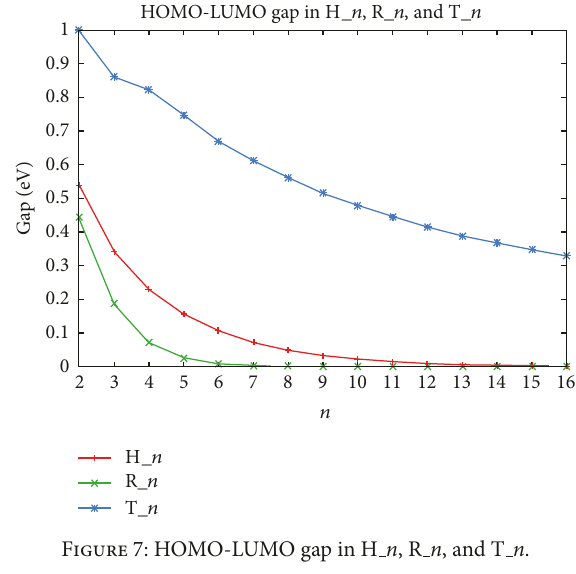
Figure 7: HOMO-LUMO gap in H n , R n , and T n .